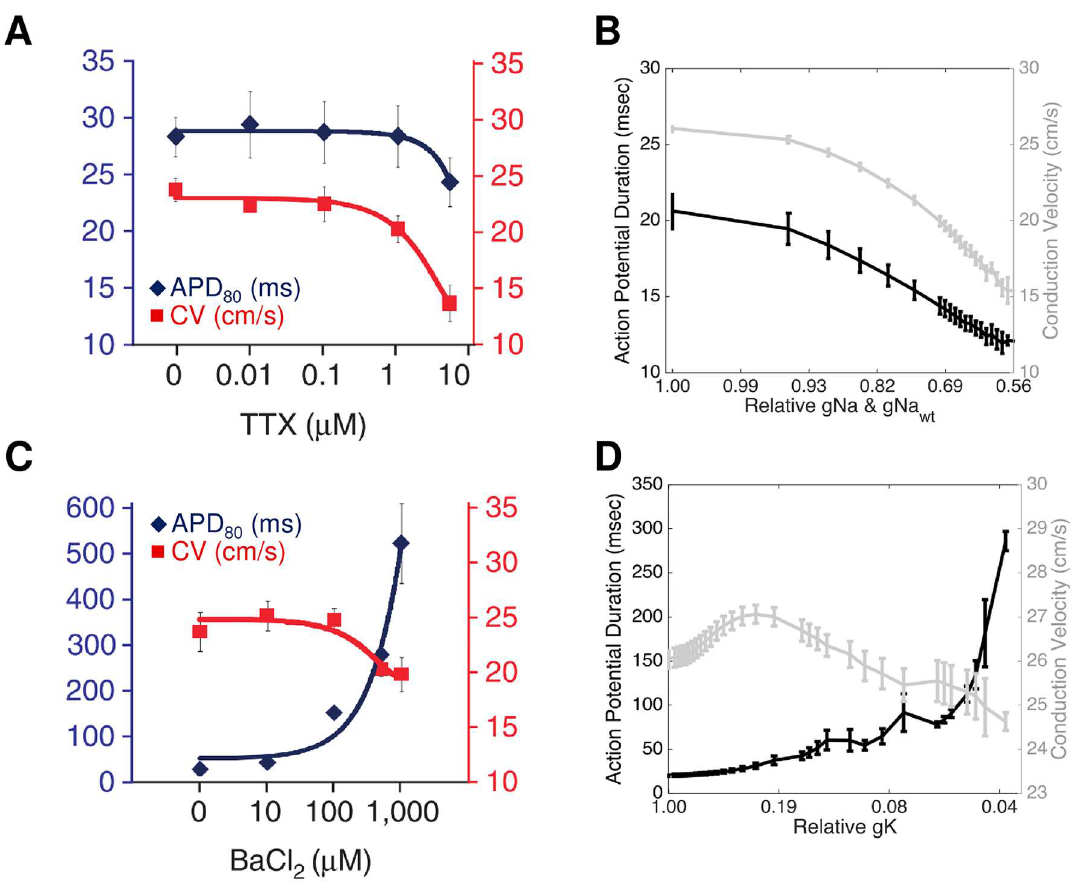
Fig 6. Comparison of simulated channel blockade with experimental findings. Simulatedblockadeof the sodium currents via TTX (B) and of IK 1 current via bariumchloride(D) qualitatively replicates the effects of experimental blockade(A: experimental TTX; C: experimental BaCl 2 ). Note that there is a sigmoidalrelationshipbetweendrug dose and degreeof block, and that the x-axis of panels B and D has beeninverse-sigmoidallytransformed to allowfor direct comparisonof simulated response and experimental results. Panels A and C from [7], used with